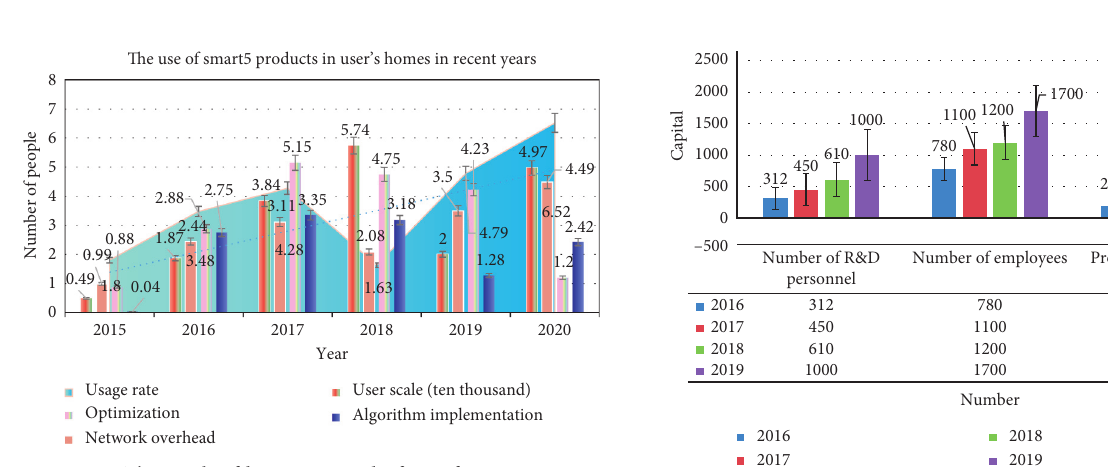
Figure 10: The stock of human capital of X software company.